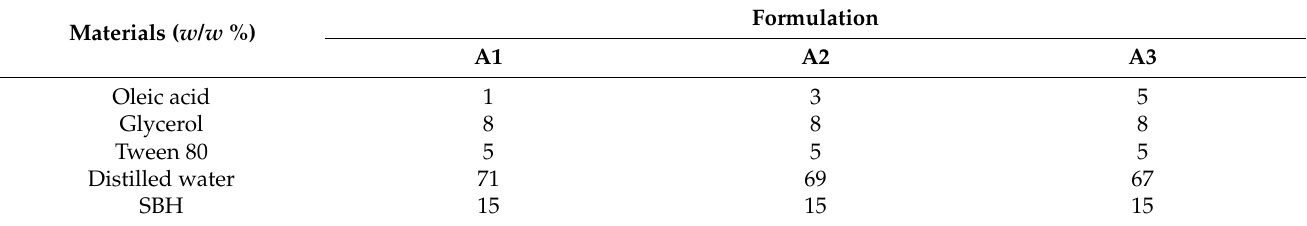
Table 1. Formulation of